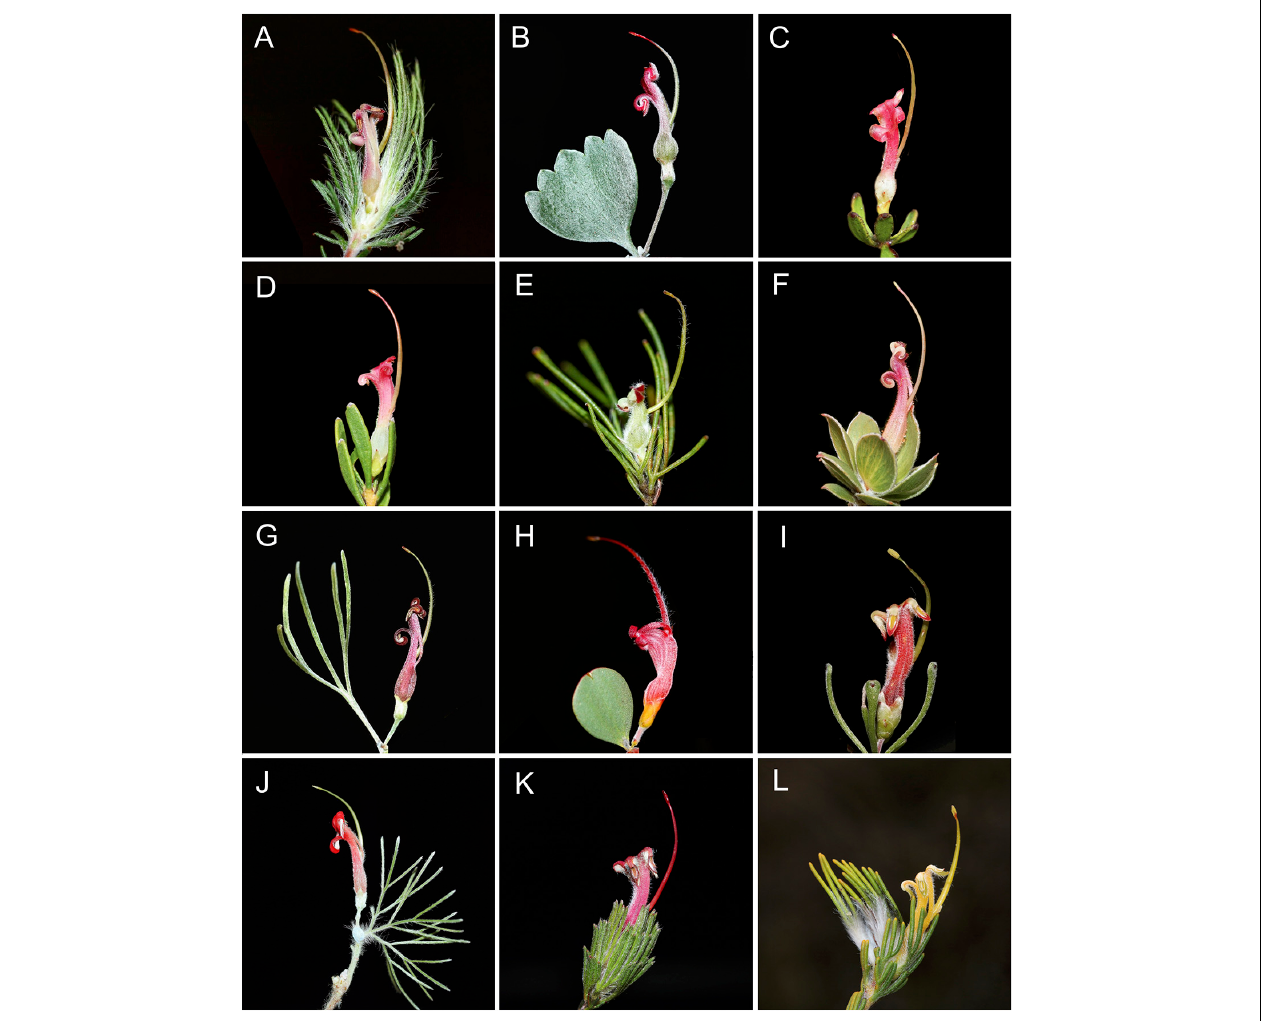
FIGURE 1 | Representative floral and leaf diversity of Adenanthos : (A) Adenanthos cygnorum subsp. chaemaephyton E.C.Nelson. (B) A. stictus A.S.George. (C) A. glabrescens subsp. exasperatus E.C.Nelson. (D) A. glabrescens E.C.Nelson subsp. glabrescens . (E) A. linearis Meisn. (F) A. venosus Meisn. (G) A. × cunninghamii Meisn. (H) A. obovatus Labill. (I) A. forrestii F. Muell. (J) A. sericeus [Labill. cultivated.] (K) A. macropodianus [E.C.Nelson.] (L) A. terminalis [R.Br.] Photos: F. J.